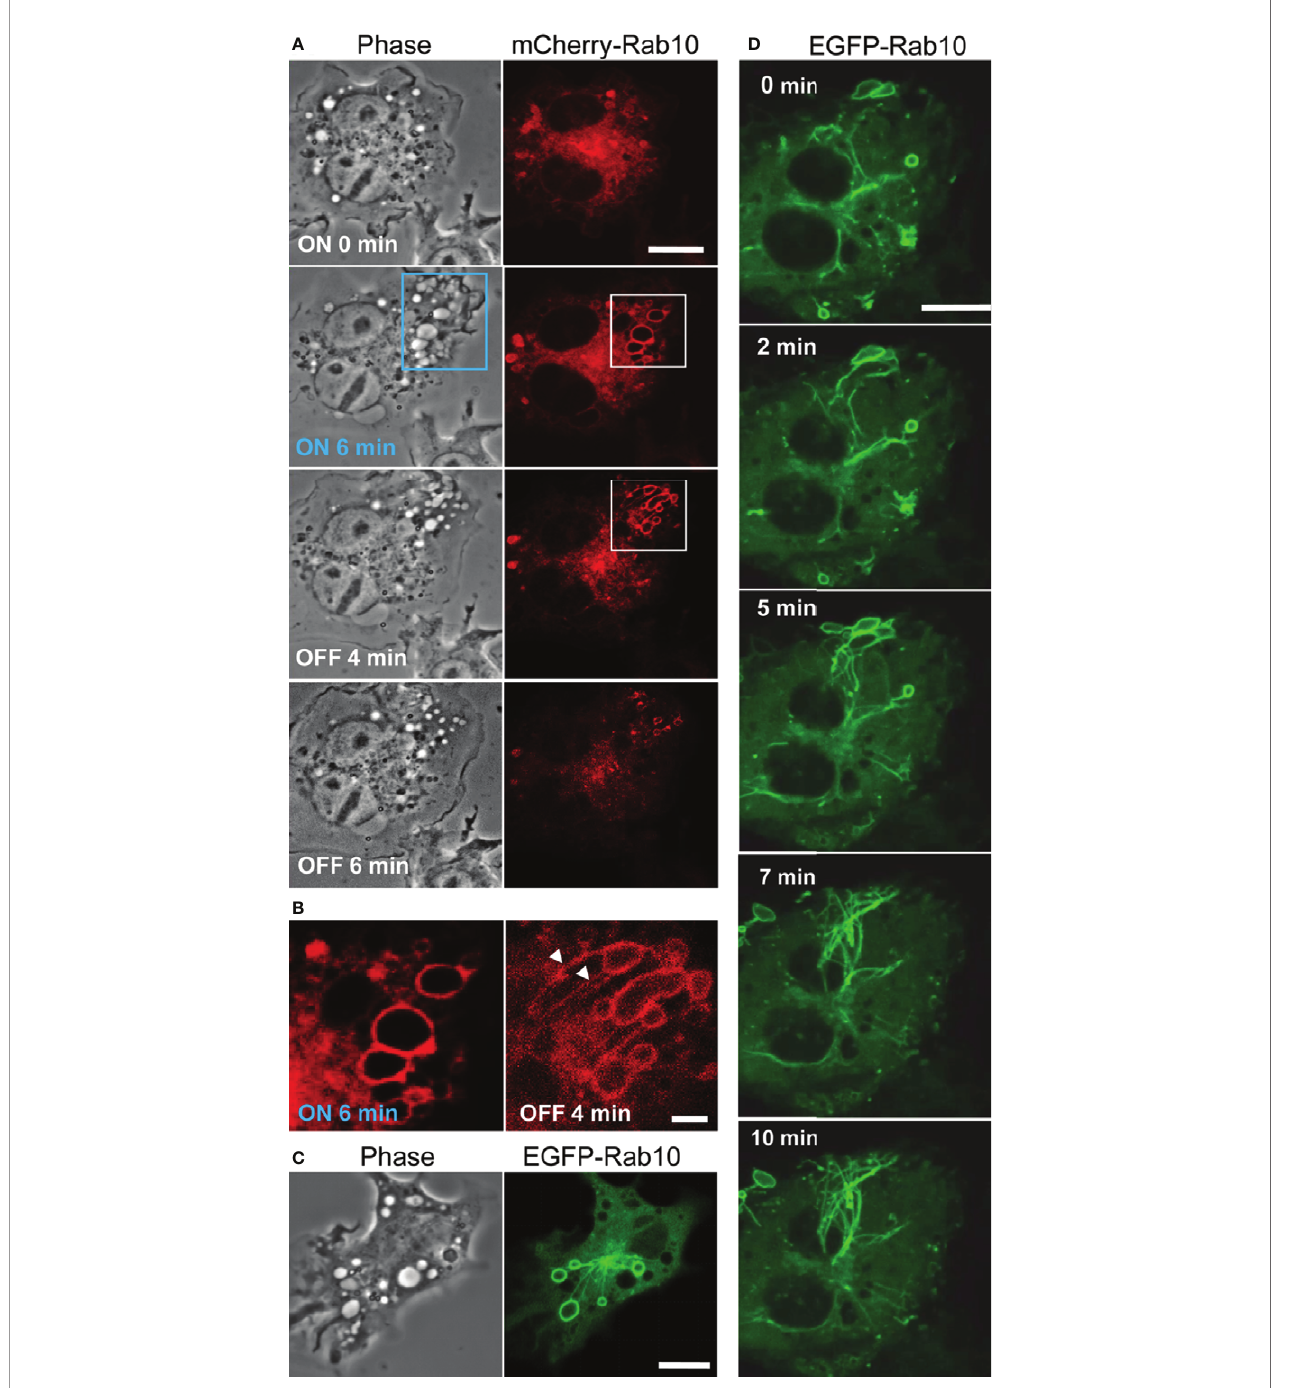
FIGURE 1 | Rab10 dynamics in live RAW264 cells under the optogenetic control of PA-Rac1 activity. (A) The blue boxed area of a cell expressing ECFP-PA-Rac1 was irradiated with a blue laser to photoactivate PA-Rac1. Phase-contrast (left) and mCherry-Rab10 (right) images were acquired at the indicated times after PA-Rac1 activation (ON) and deactivation (OFF). Scale bar =10 m m. (B) Enlarged images of the white boxed area in (A) Following local PA-Rac1 activation, Rab10- positive premacropinosomes were formed in the area. After PA-Rac1 OFF, a few Rab10-positive tubules extended from a premacropinosome (arrowheads). Scale bar = 2 m m. (C) Representative phase-contrast and EGFP-Rab10 fl uorescence images of RAW264 cells during PA-Rac1 ON-OFF cycles. (D) Confocal time-lapse microscopy of EGFP-Rab10 in RAW264 cells during PA-Rac1 ON-OFF cycles. Selected frames from the time-lapse movie are presented. Elapsed times are shown in the frame. Scale bar = 10 m m. The corresponding movie is available in the Supplementary Material Movie 2